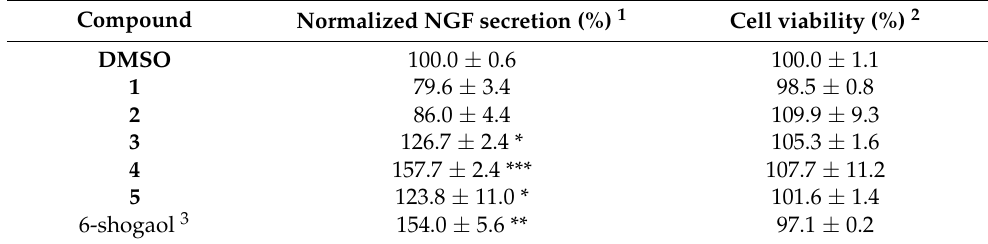
Table 3. Effects of the isolated compounds ( 1–5 ) on nerve growth factor (NGF) secretion in C6 cells.